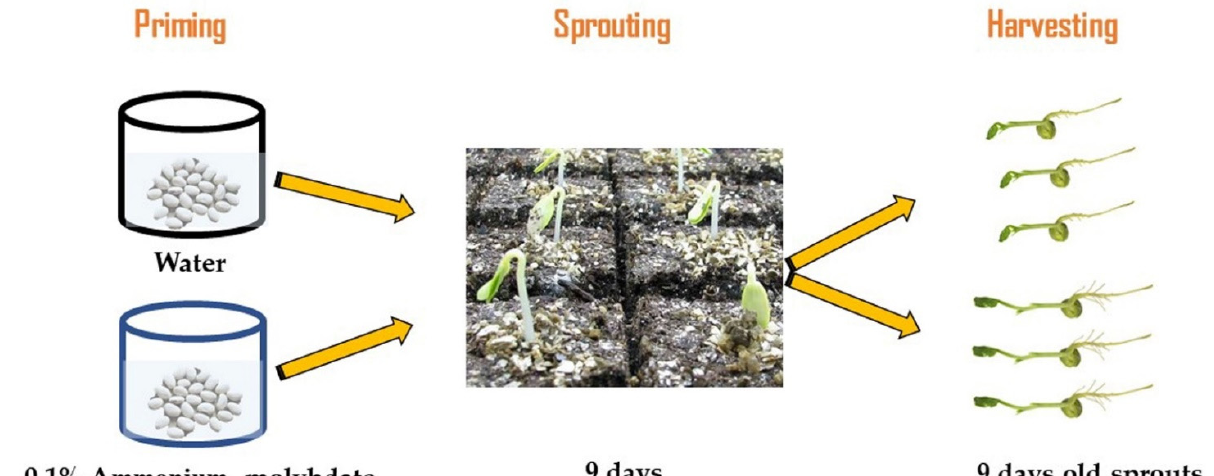
Figure 6. Flow chart of the experimental design.